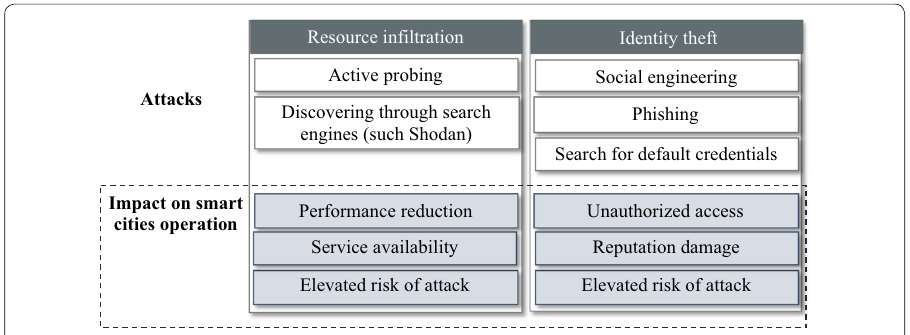
Fig. 4 Exploratory threats in smart cities’ settings: attacks and impacts